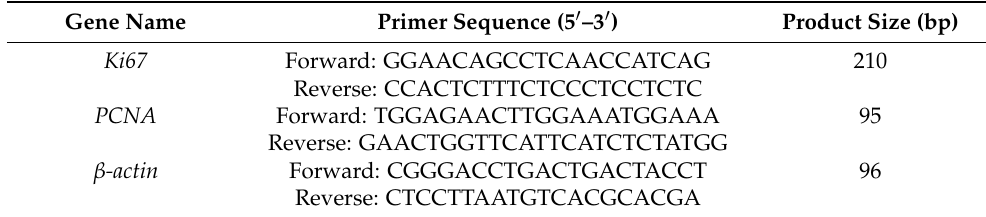
Table 1. Primers used in this